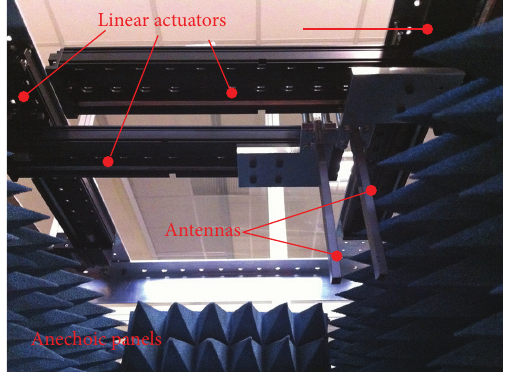
Figure 3: Lateral view of the setup.